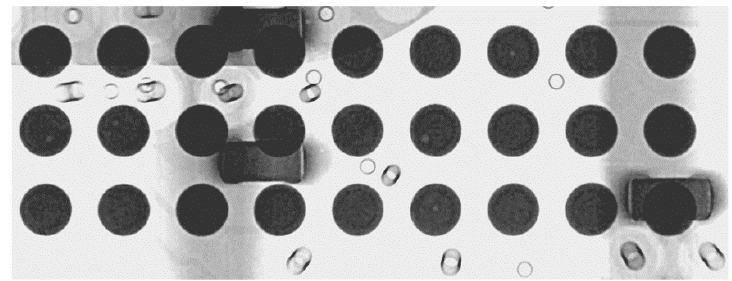
Figure 6. The X-ray detection result of an intact sample.